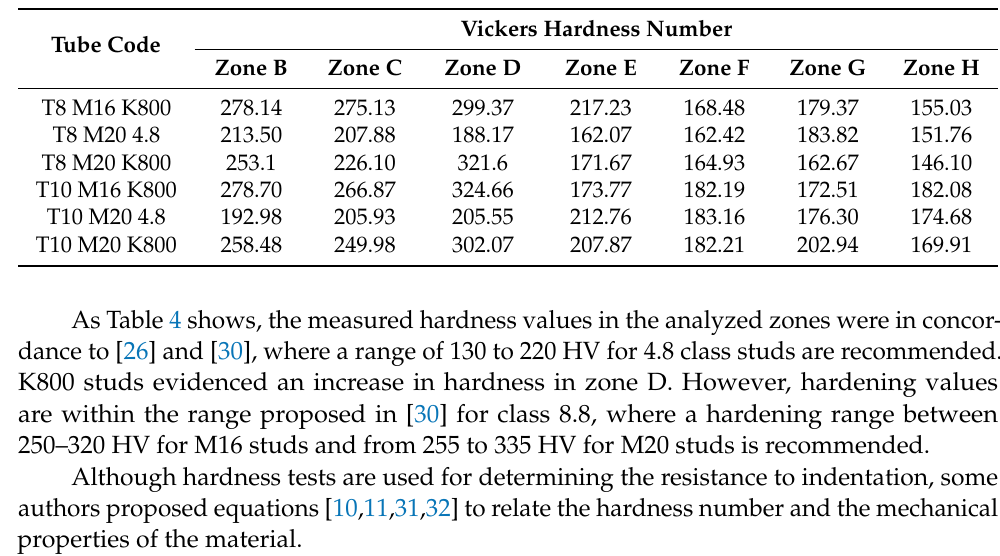
Table 4. Vickers hardness in the different zones of the